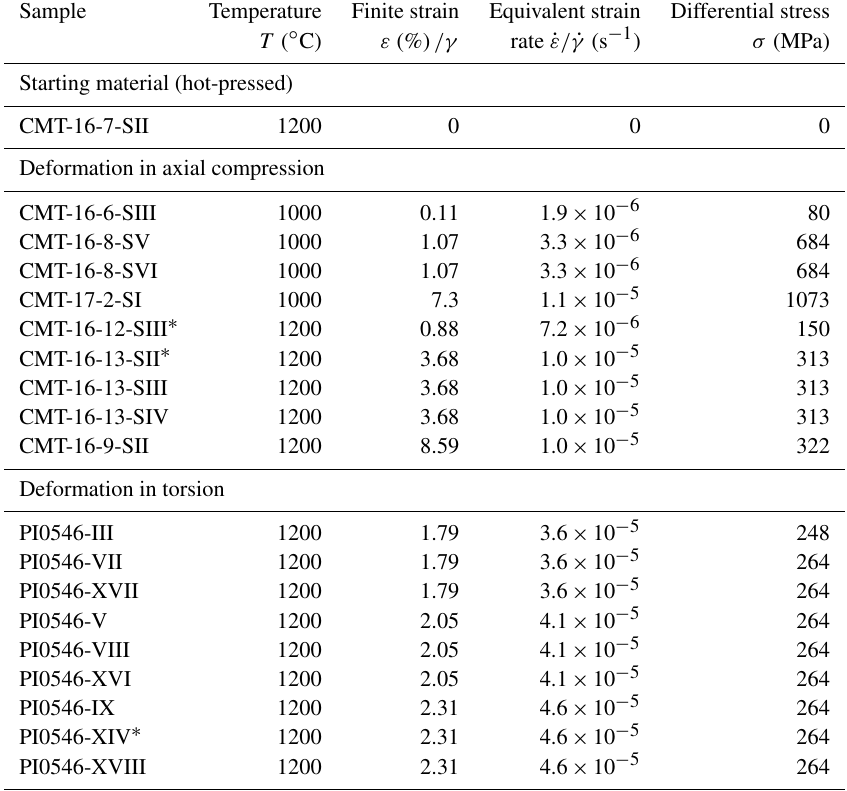
Table 1. Experimental parameters and mechanical results for the selected deformation experiments investigated by EBSD in this study. Original deformation curves (stress–strain) are reported in Demouchy et al. (2012) and Thieme et al. (2018). Uncertainties are up to ± 2 ◦ C for T , 20MPa for stress, and negligible for the strain and strain rate ( <